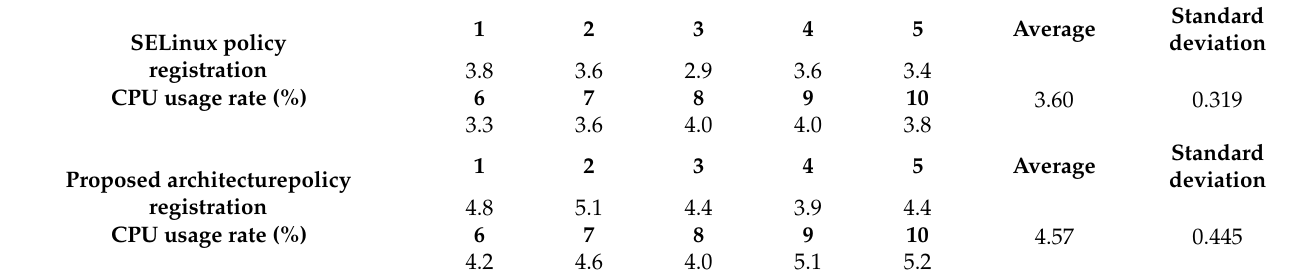
Table 2. Central processing unit usage rates of SELinux and the proposed architecture.